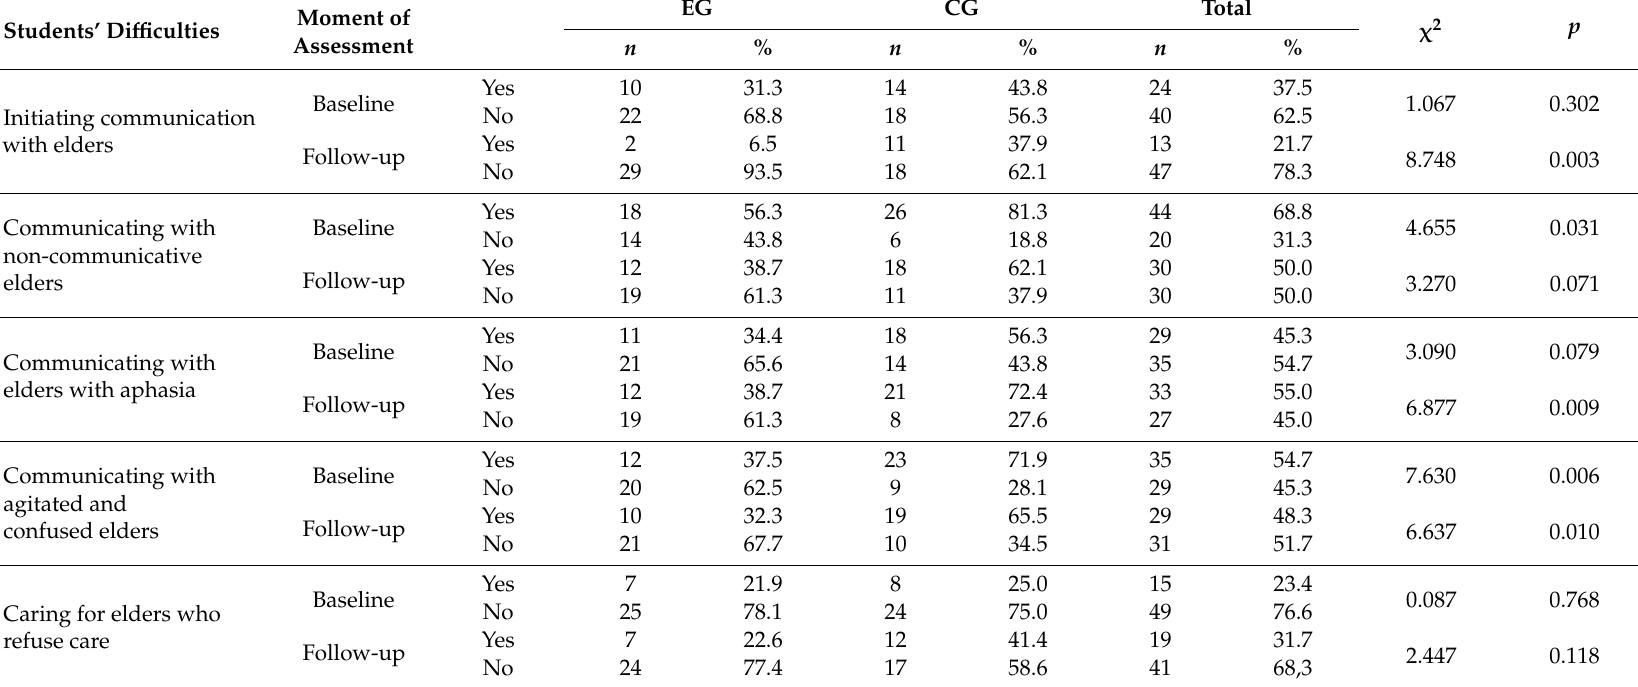
Caring for elders who refuse care